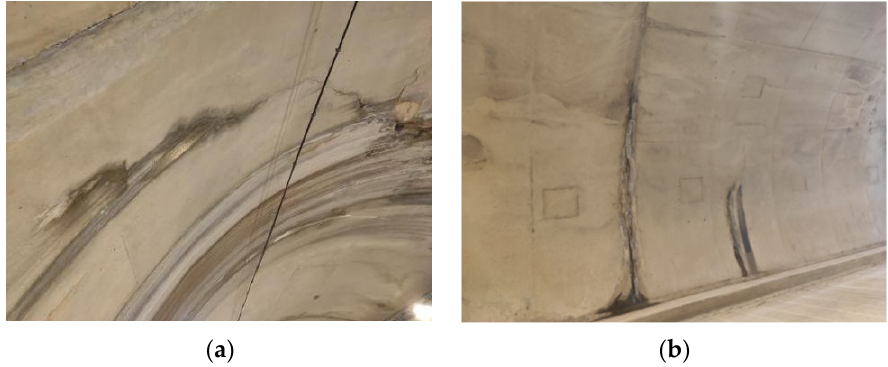
Figure 1. Tunnel leakage. ( a ) leakage from crack; ( b ) leakage from construction